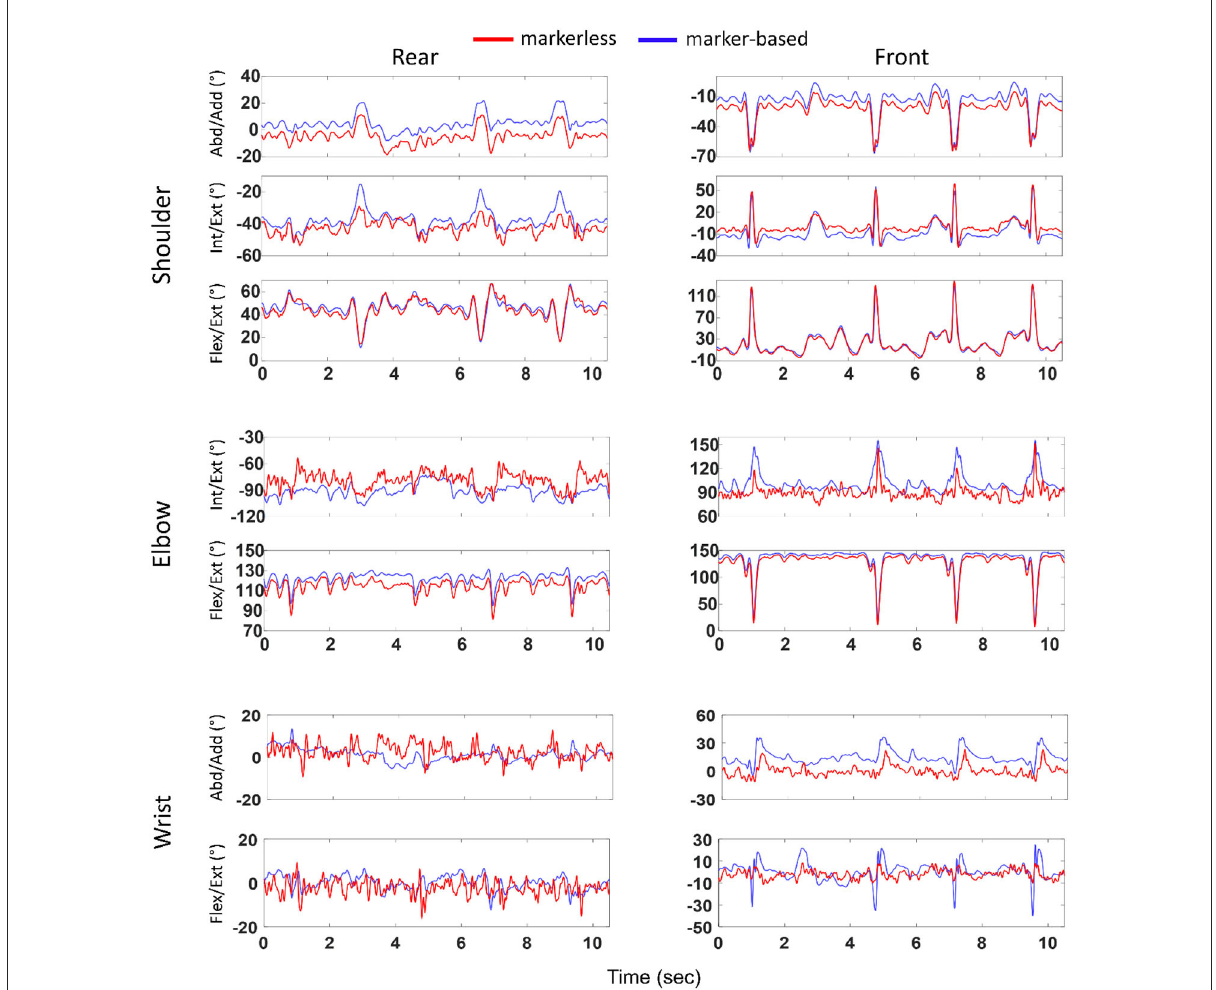
FIGURE3 Joint angles (ordinate) at the shoulder, elbow, and wrist computed with marker-based and markerless methods and represented over time (abscissa). Left and right columns represent joints of the rear and front limbs, respectively. Example shown for the second athlete and first boxing trial. Blue and red colors represent marker-based and markerless joint angles,